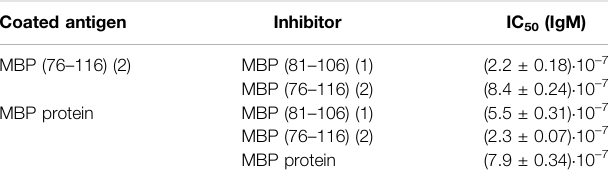
TABLE 2 | Calculated IC 50 values of anti-MBP (76 – 116) or anti-MBP protein IgM antibodiesofMSserumtoMBP(76 – 116)(2)andMBP(81 – 106)(1).Valuesare reported as 95% con fi dence interval for the calculated mean IC 50 ± the standard error